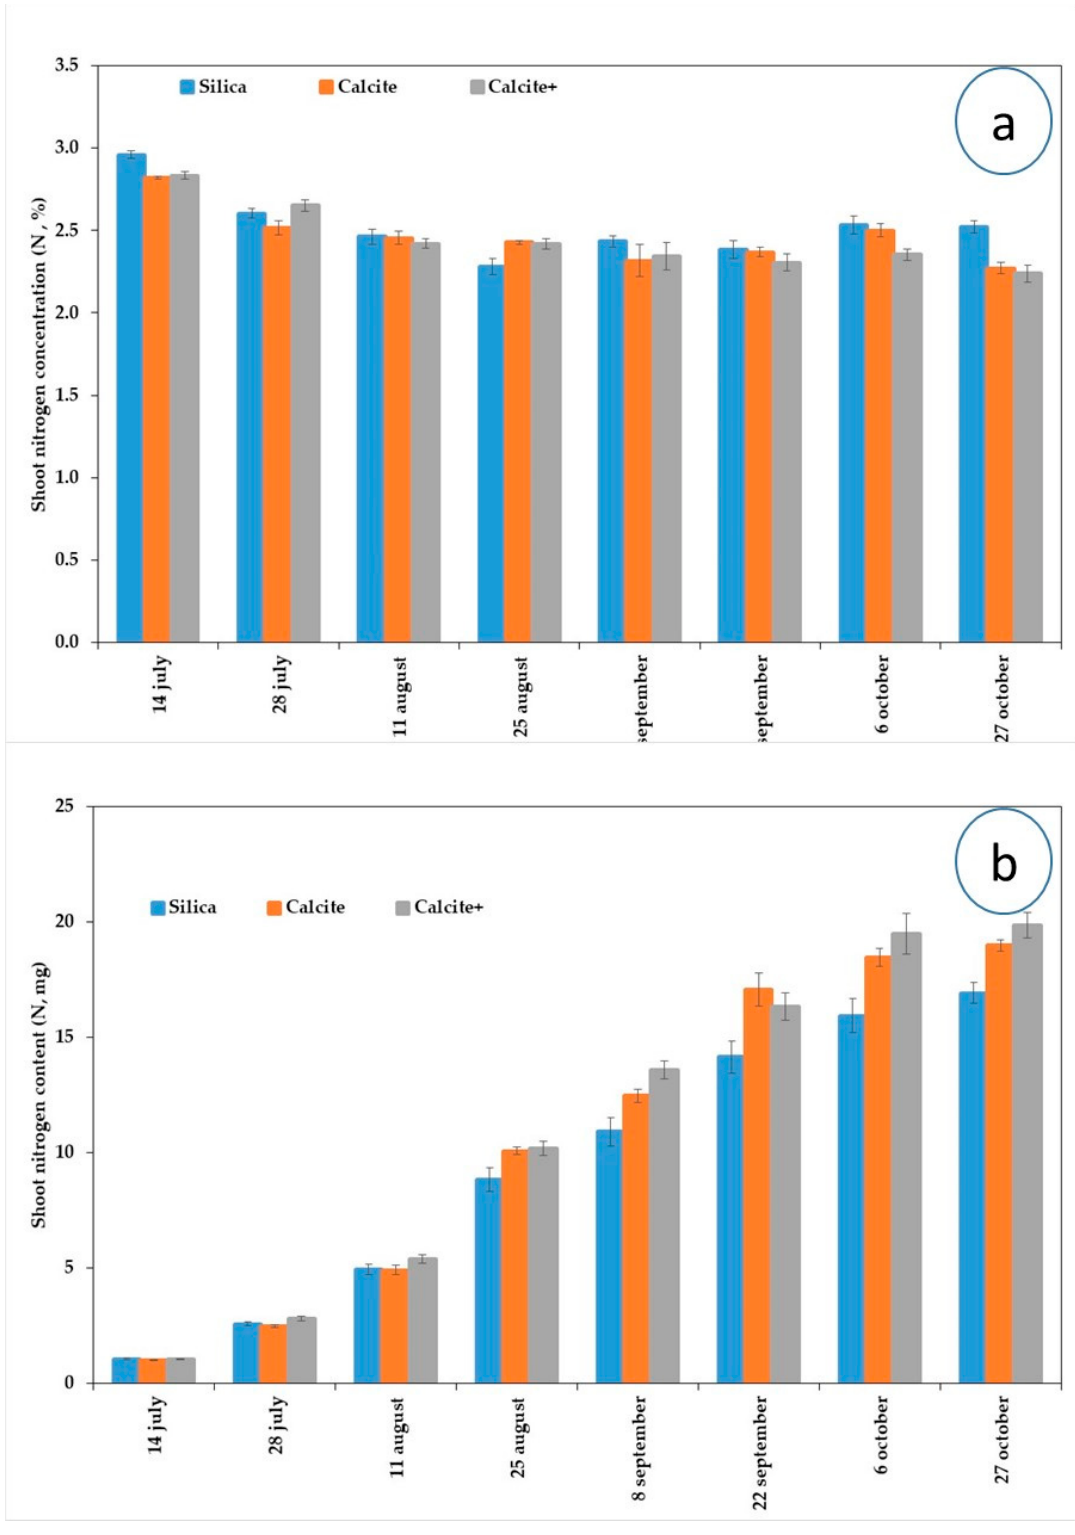
Figure 11. Variations ( a ) in the nitrogen concentration (N, %), and ( b ) in the nitrogen content (N, mg) in the shoots during the first growing season of white spruce seedling (1 + 0) depending on the covering material (silica: 29 g/cavity, calcite: 24 g/cavity and calcite+: 31 g/cavity).